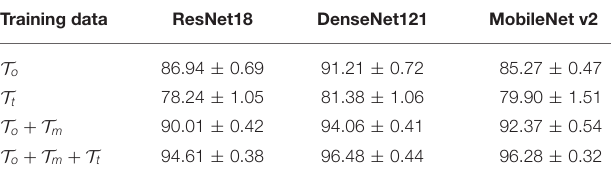
TABLE 5 | Verification of SCIT.